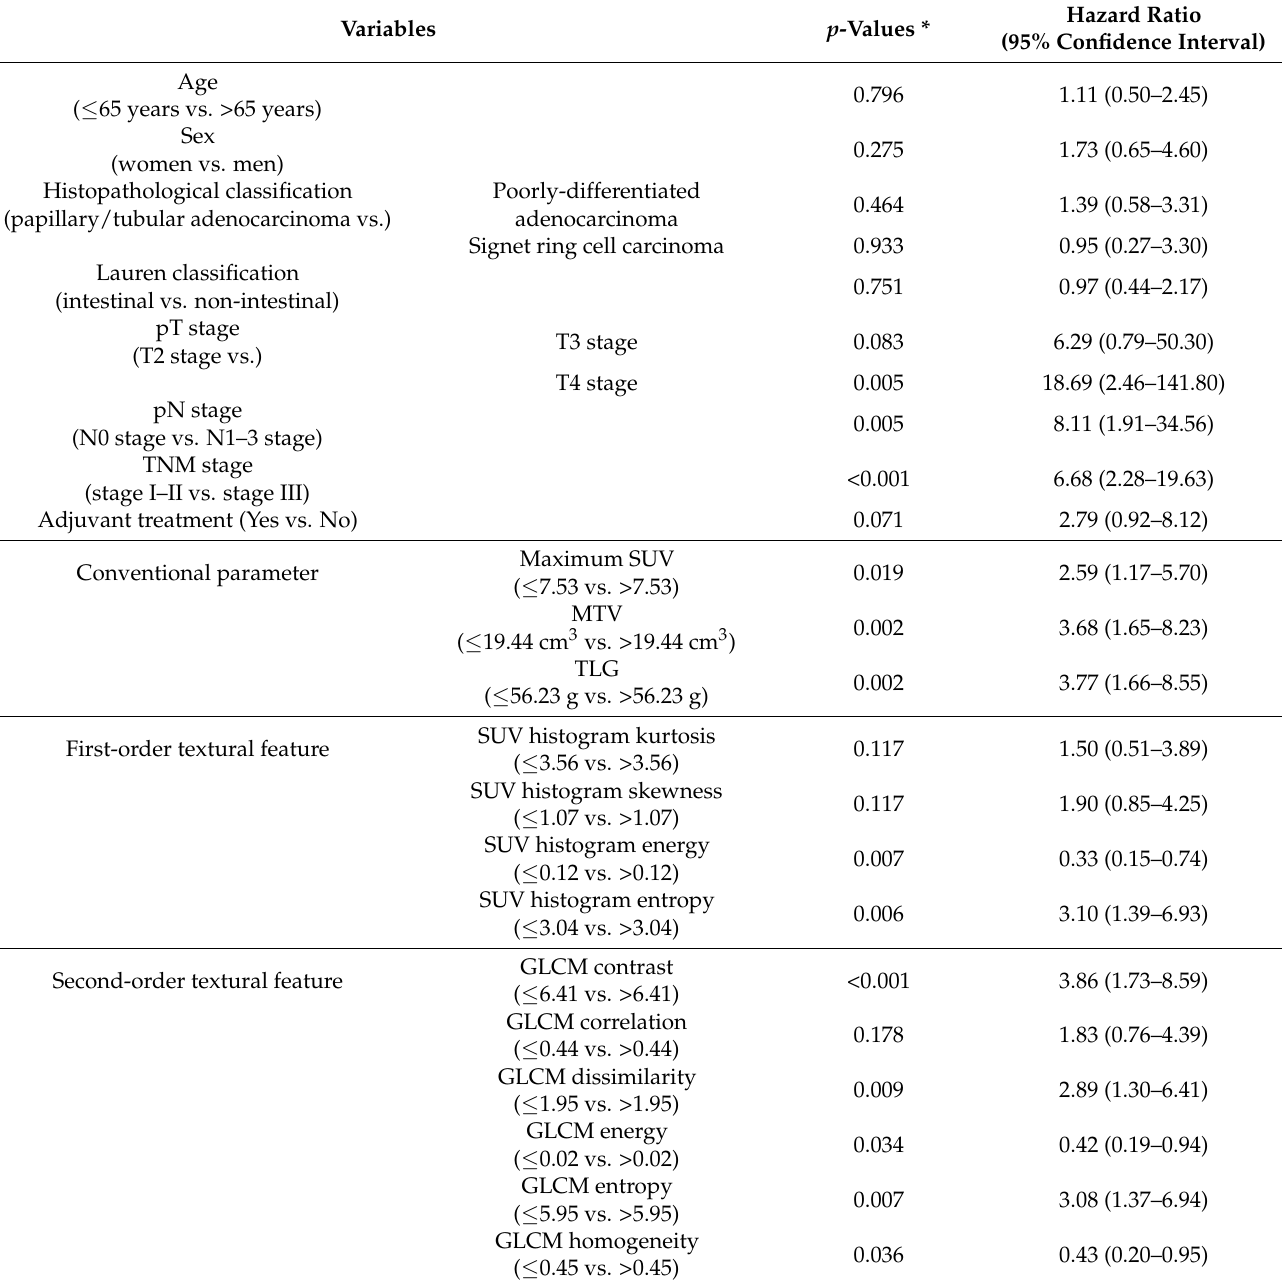
Table 3. Univariate analysis for predicting